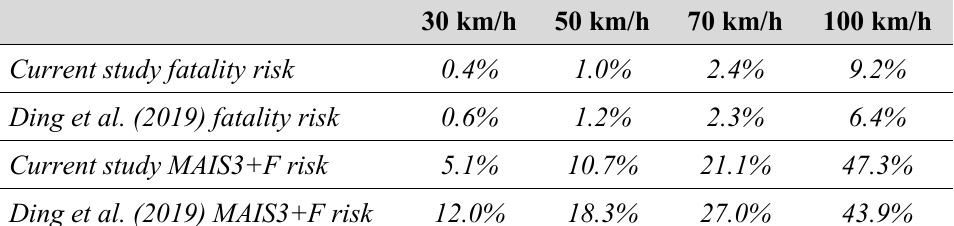
Table 7. Comparison of motorcyclist fatality and MAIS3+F risks to previous